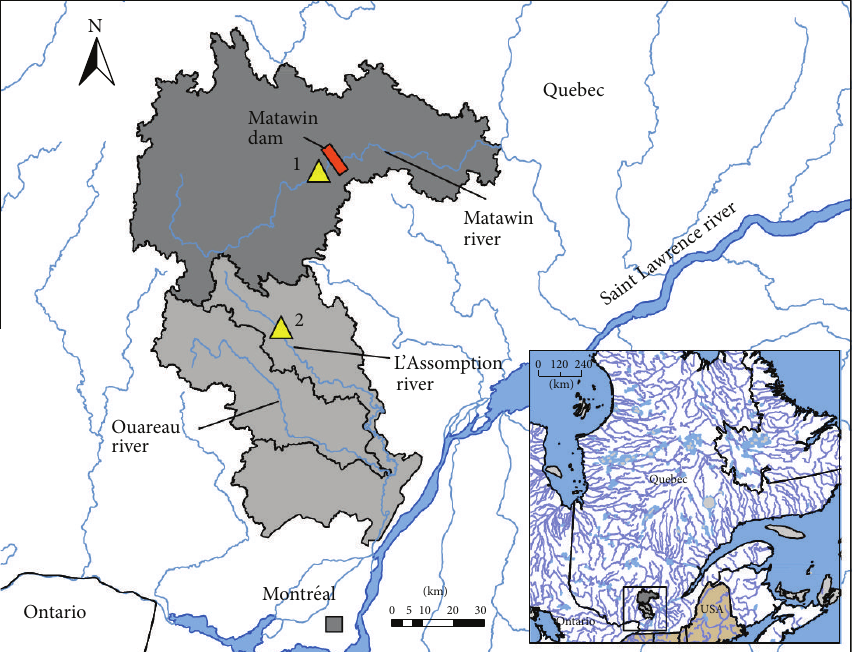
Figure 1: Location of two watersheds. 1: Saint-Michel-Des-Saints hydroclimatic station located in Matawin River (forested basin); 2: Joliette hydroclimatic station located in L’Assomption River (agricultural